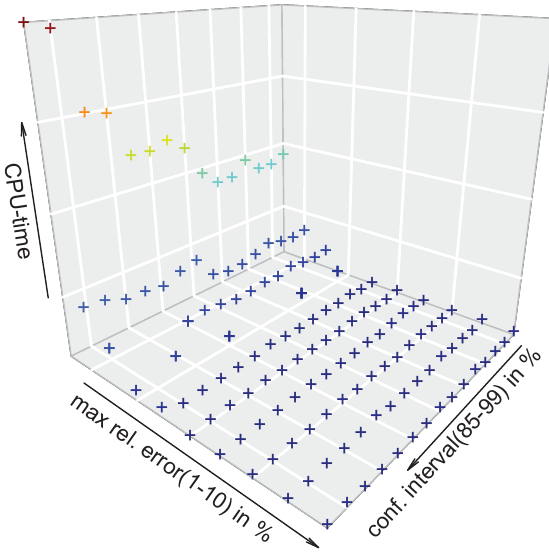
Figure 4: Maximum relative error and confidence interval in relation to used CPU time